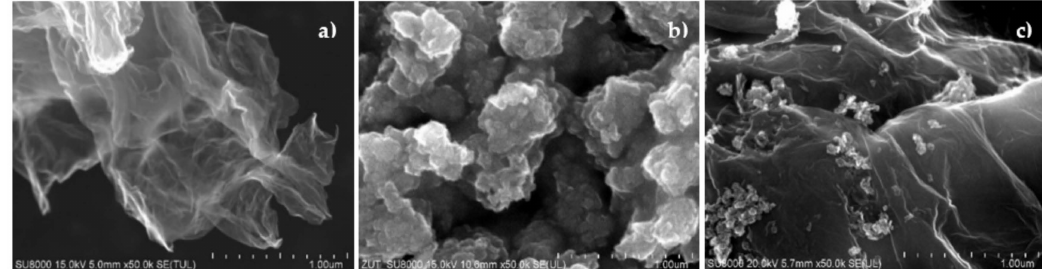
Figure 4. SEM images of ( a ) rGO, ( b ) TiO 2 , and ( c ) TiO 2